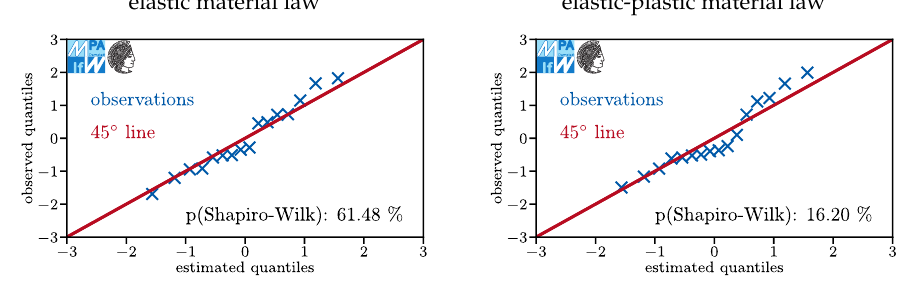
Figure A7. Quantile-quantile plots for 50CrMo4 specimens in laboratory air; 919MPa ultimate tensile strength; K t = 1.